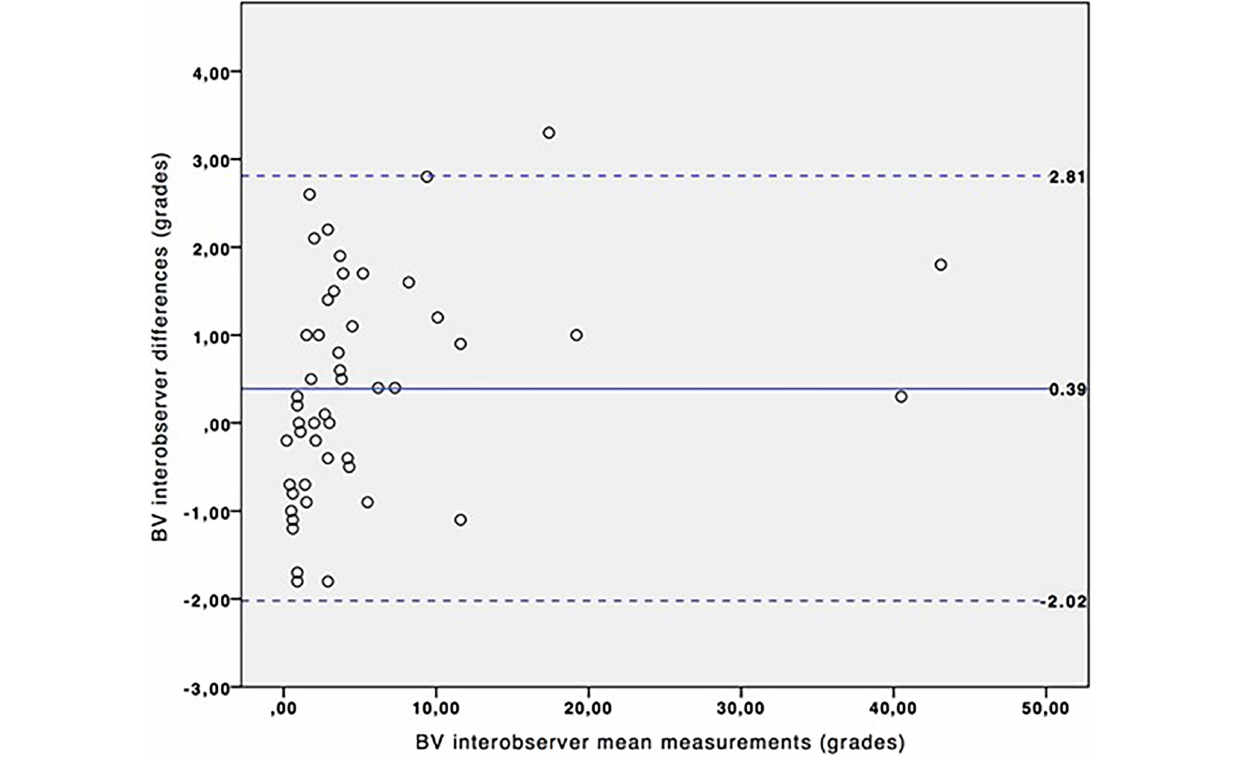
Frontiers in Medicine |